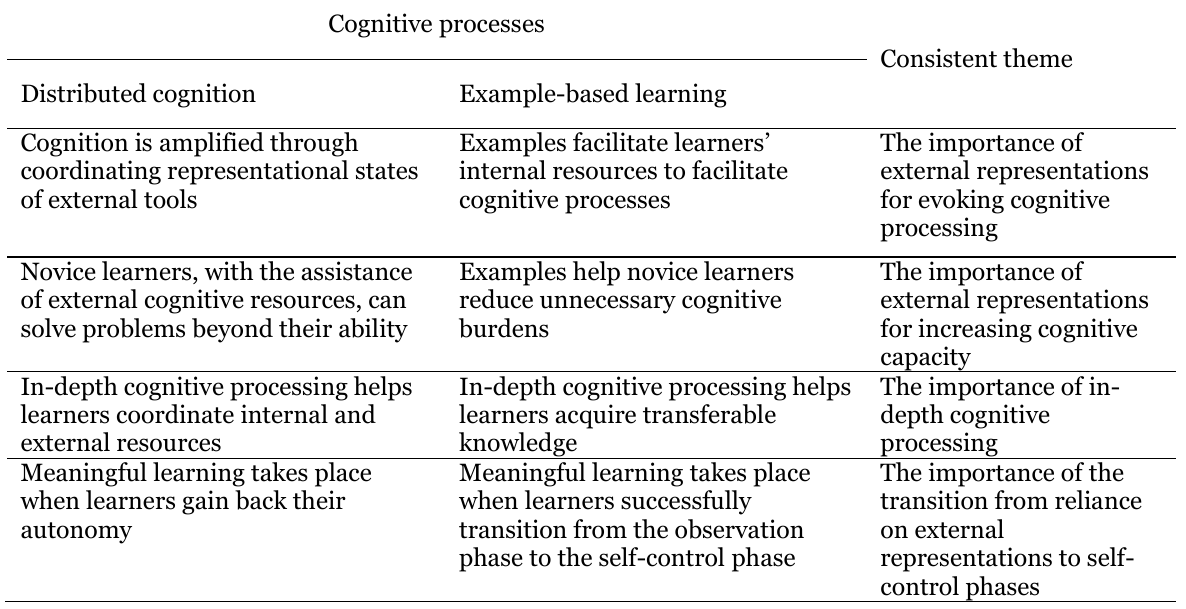
Consistent Themes in Distributed Cognition and Example-Based Learning Regarding Cognitive Processes Cognitive